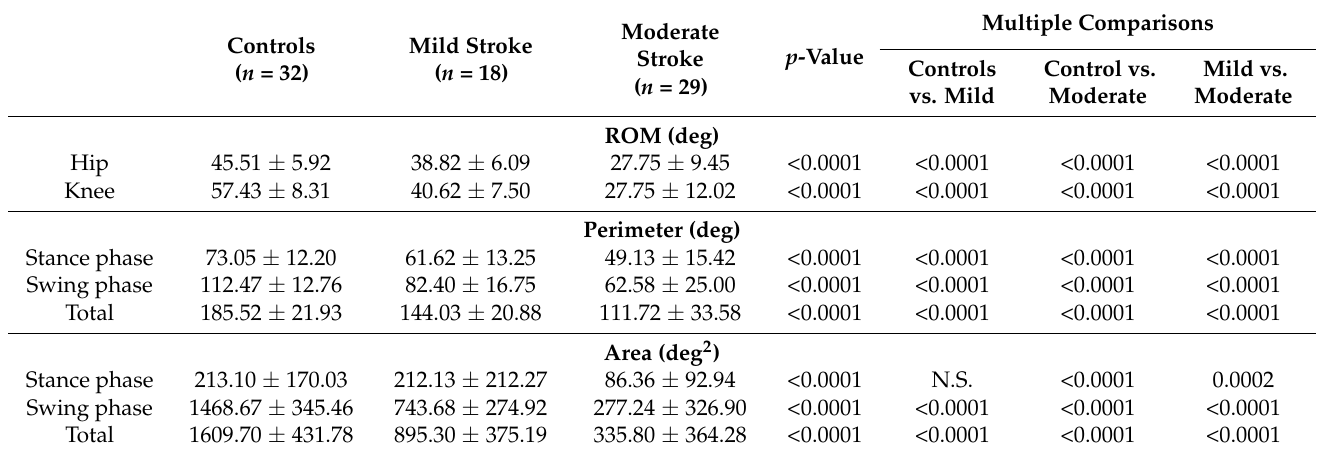
Figure 4. Representative hip–knee cyclograms of three groups according to the hip and knee joint ROM. ( a ) Representative from control group; ( b ) Representative from mild stroke group; ( c ) Representative from moderate stroke group; ( d ) Representative from moderate stroke group, describing hyperextension of the knee joint through the stance phase. Table 2. Hip-knee cyclogram parameters. The results are presented as mean ± standard deviation, or n . p -values were calculated by Kruskal–Wallis tests. Multiple comparisons between groups were calculated by Mann–Whitney U-tests with Bonferroni